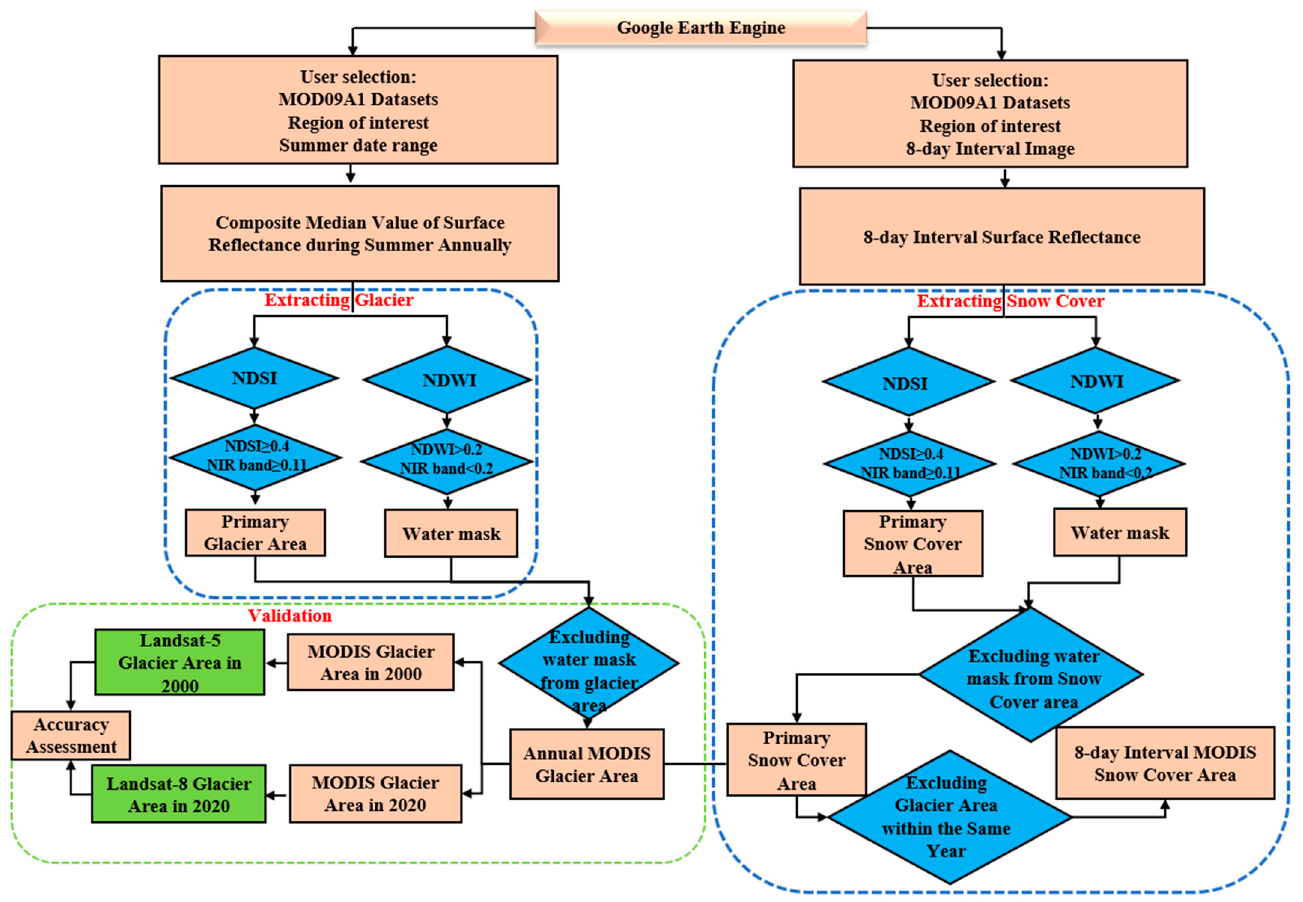
Figure 2. Work-flow implemented in the Google Earth Engine (GEE) to delineate glaciers and intermittent snow cover. NDSI, Normalized Difference Snow Index; NDWI, Normalized Difference Water Index.